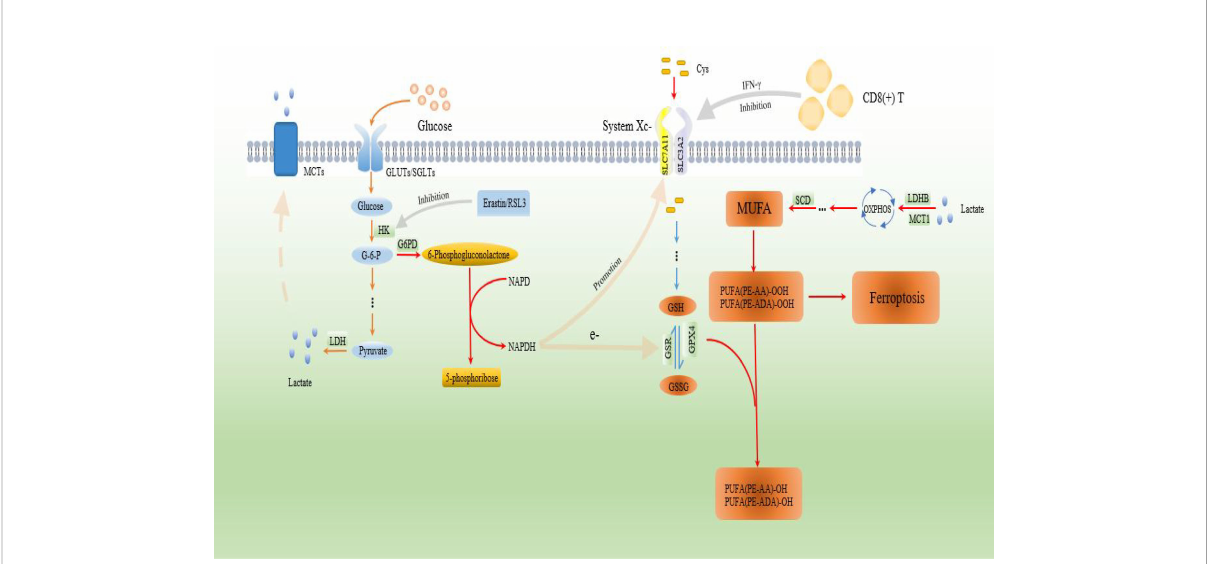
FIGURE 3 The association between PC glycolysis and ferroptosis and TME. The NAPDH that is produced by the PPP pathway in PC cells provides suf fi cient reducing equivalents for the synthesis of GSH. In addition, a large amount of lactate produced by the glycolytic pathway in cancer cells and TME undergoes a series of enzymatic reactions to generate MUFA, which reduces ferroptosis occurrence. However, the IFN- g derived from CD8(+) T cells in the TME induces ferroptosis by inhibiting system Xc-, thereby suppressing malignant progression of